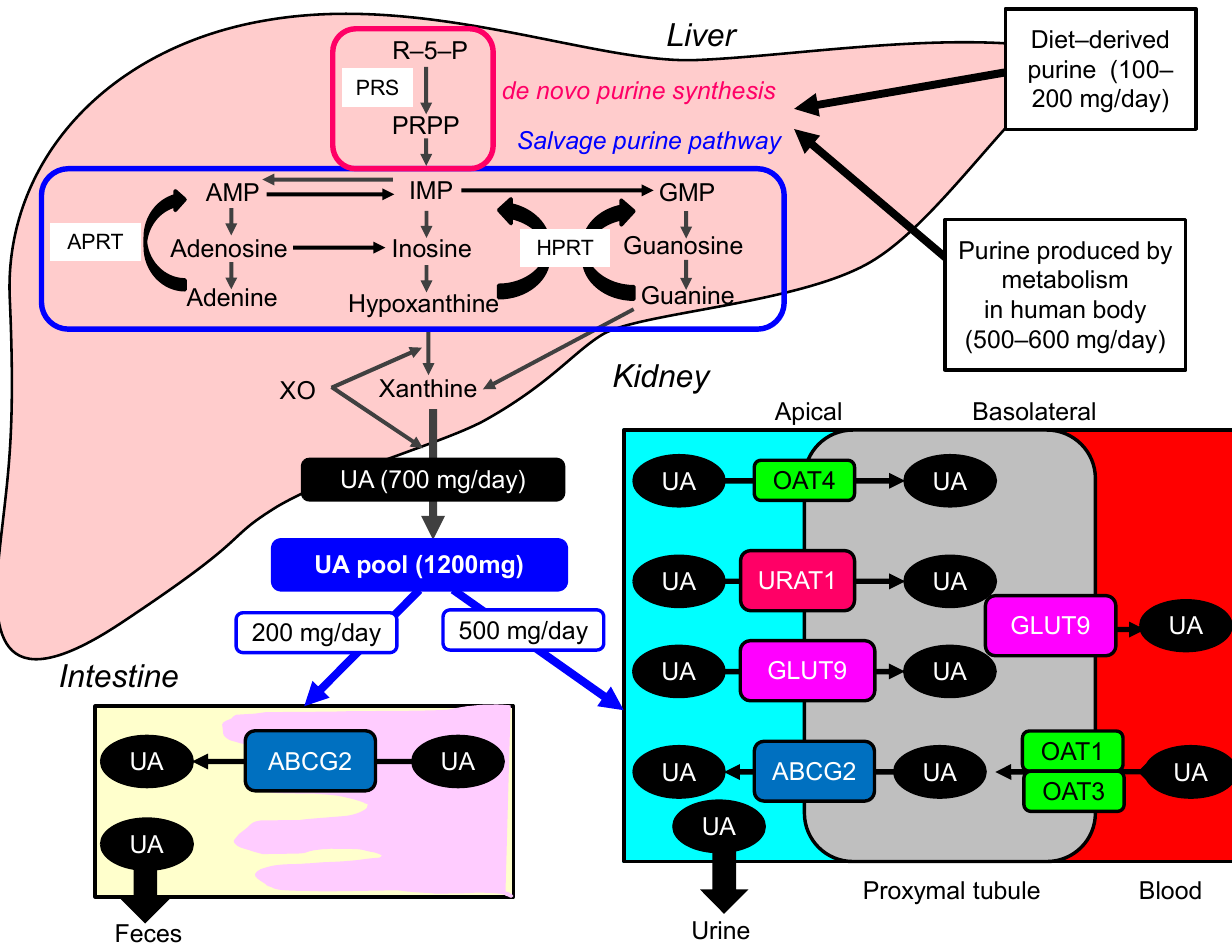
Figure 1. Synthesis and excretion of UA. ABCG2, ATP-binding cassette, subfamily G, 2; AMP, adenosine monophosphate; APRT, adenine phosphoribosyltransferase; GMP, guanine monophosphate; GLUT9, glucose transporter 9; HPRT, hypoxanthine-guanine phosphoribosyltransferase; IMP, inosine monophosphate; OAT, organic anion transporter; PRPP, phosphor-ribosyl-pyrophosphate; PRS, phosphor-ribosyl-pyrophosphate synthetase; R-5-P, ribose-5-phosphate; UA, uric acid; URAT1, urate transporter 1; XO, xanthine oxidase.